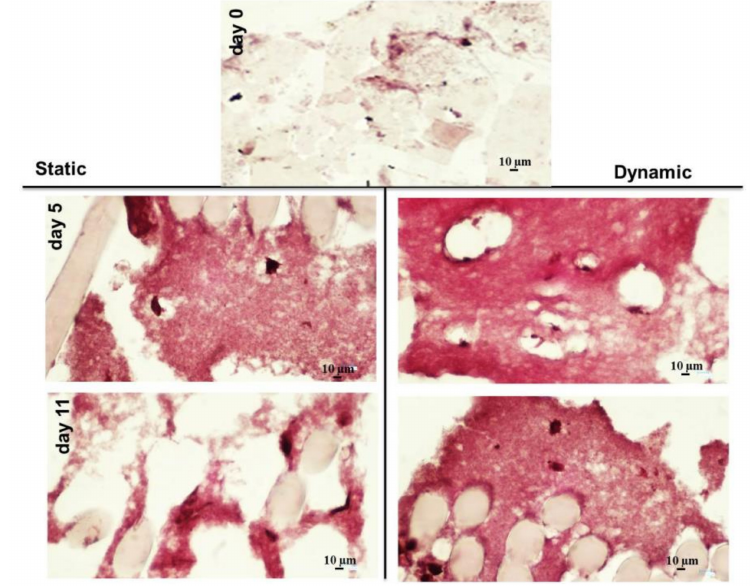
Figure 6. Histology characterization of the overall HY-FIB sca ff old structure with Sirius Red staining. HY-FIB sca ff olds in both static and dynamic culture at Days 5 and 11 are reported; the overall sca ff